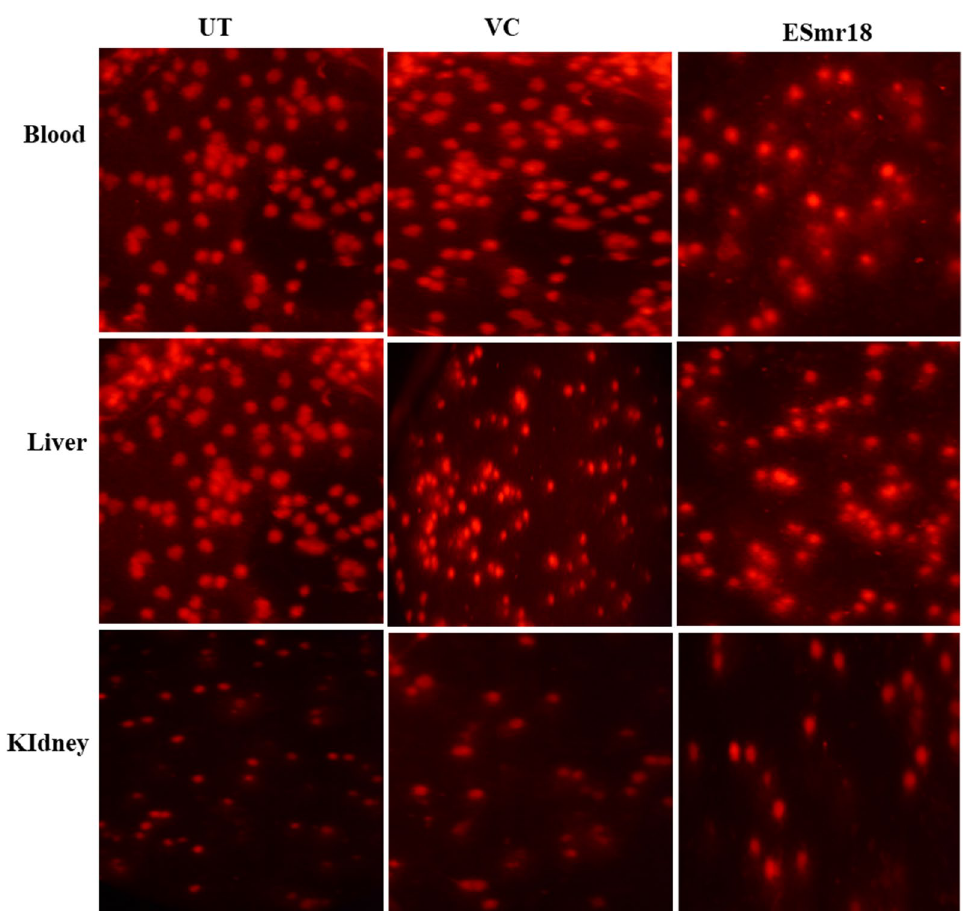
Fig. 7 Comet assay of the blood, liver, and kidney cells of C. mrigala. UT: untreated; VC: vehicle control; ESmr18; crude ESmr18 treated. Error bars are representative of mean